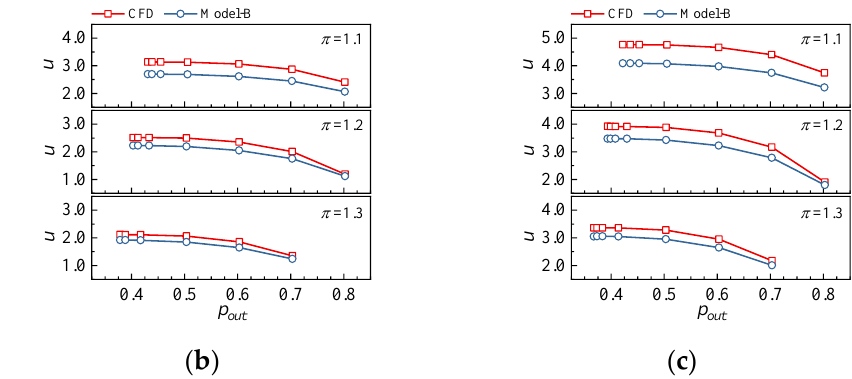
Table 2. Calibration database for the VABI model.